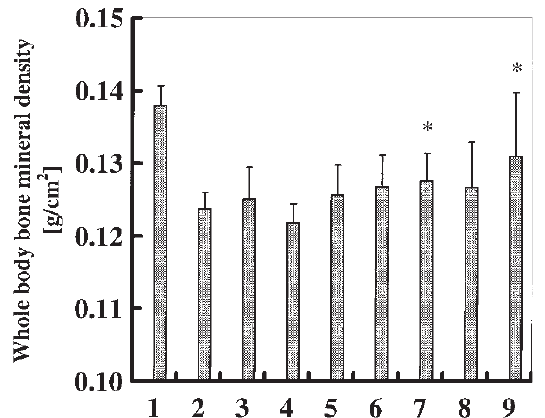
FIGURE 1 The effect of E. faecium (EF), selenium (SSe), methotrexate (MTX) and their combinations on whole body bone mineral density (BMD) in rats assessed on day 50. Animals were grouped as follows: (1) nonarthritic untreated controls; (2) AA untreated controls; (3) AA rats treated with EF 15mg/kg, 5 days a week; (4) AA rats treated with SSe (0.050mg/kg containing 0.015mg/kg selenium), 5 days a week; (5) AA rats treated with combination EF þ SSe; (6) AA rats treated with MTX 0.6mg/kg/week; (7) AA rats treated with combination MTX þ EF; (8) AA rats treated with combination MTX þ SSe; (9) AA rats treated with combination MTX þ EF þ SSe. Data represent mean values ^ SD for 10 rats. Significantly different from arthritic control rats: * p , 0 : 05 :